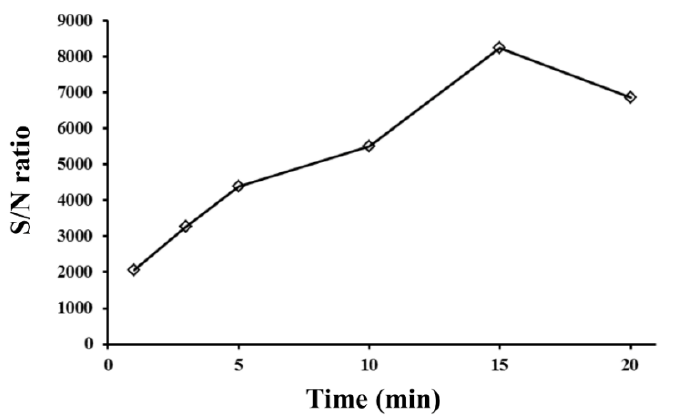
Figure 4. Effect of extraction time on the S/N ratio of posaconazole obtained from EME. Experimental conditions: sample volume, 8 mL; applied voltage, 80 V; stirring rate, 100 rpm; and posaconazole concentration, 0.50 µ M. All other conditions were identical to those outlined in Figure